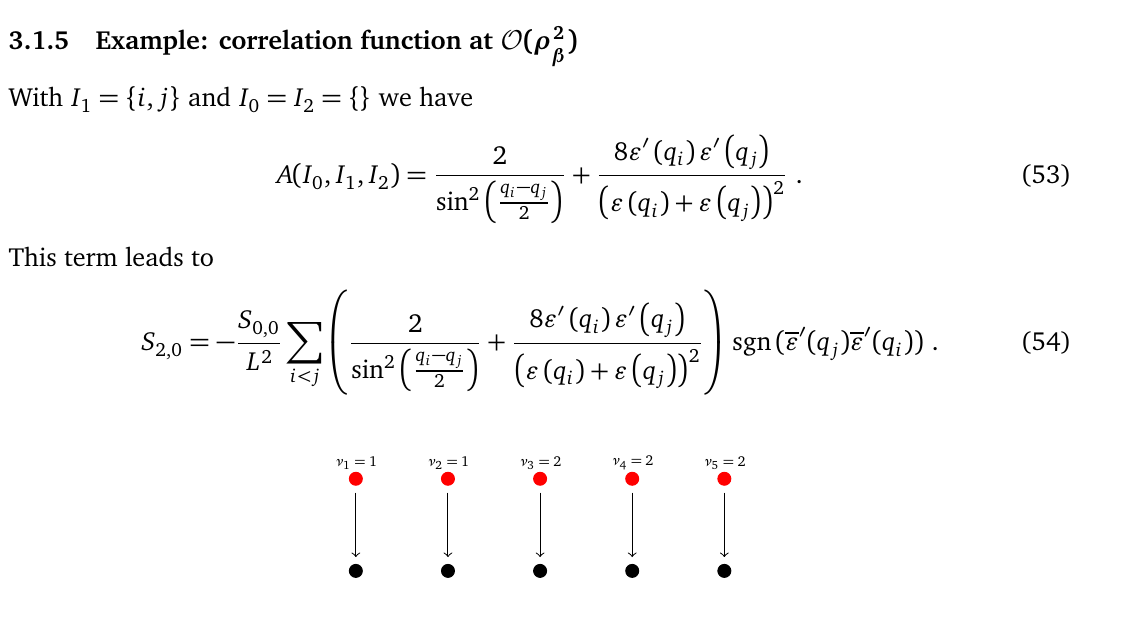
Figure 3: Sketch of configurations contributing to S